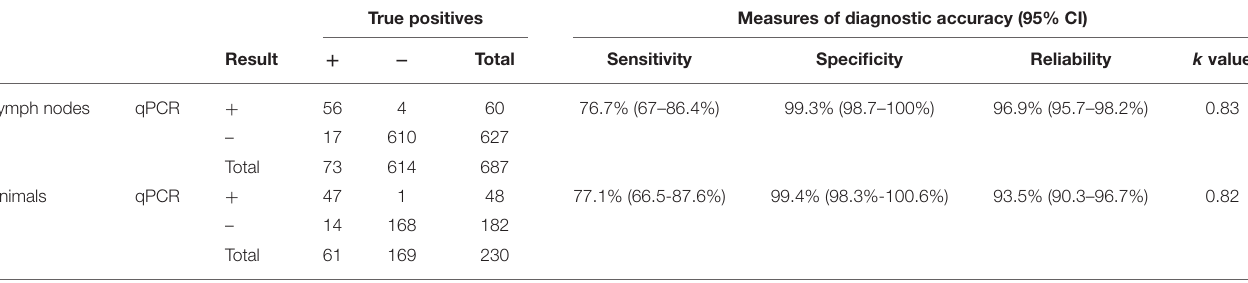
TABLE 2 | Diagnostic performance of direct qPCR targeting IS 6110 compared with microbiological culture as gold standard analyzing 687 lymph nodes belonging to 230 cattle.